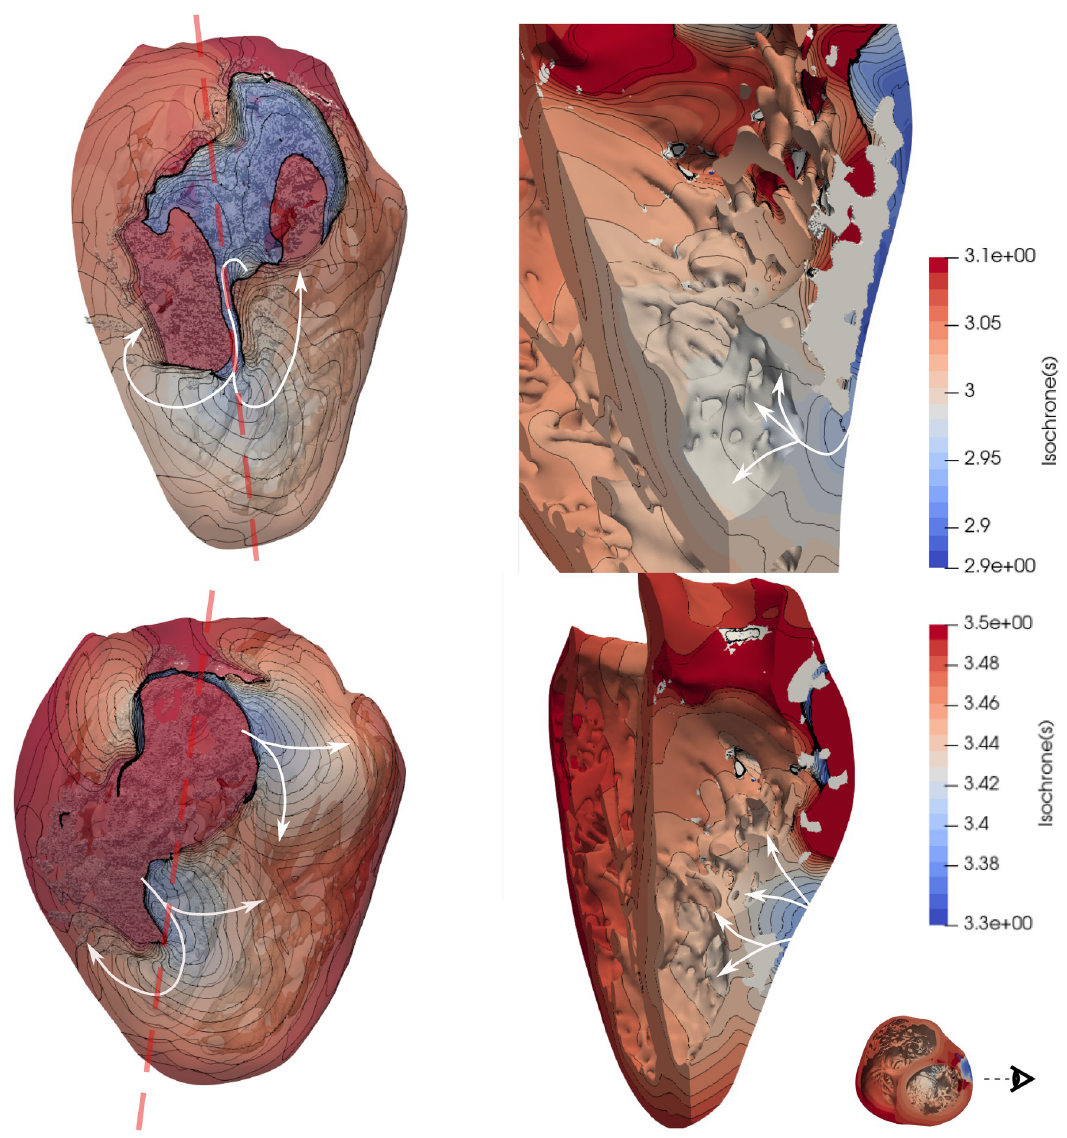
Fig 10. Isochrone map of the ventricular tachycardia obtained from the female detailed simulations with RVApex stimulus location (same as in Fig 9A) at two different time intervals, as shown in the color bars. Dense scar is observed in white color. The papillary muscle was removed for ease of visualization on the right panels. S1 Video in S1 File shows this